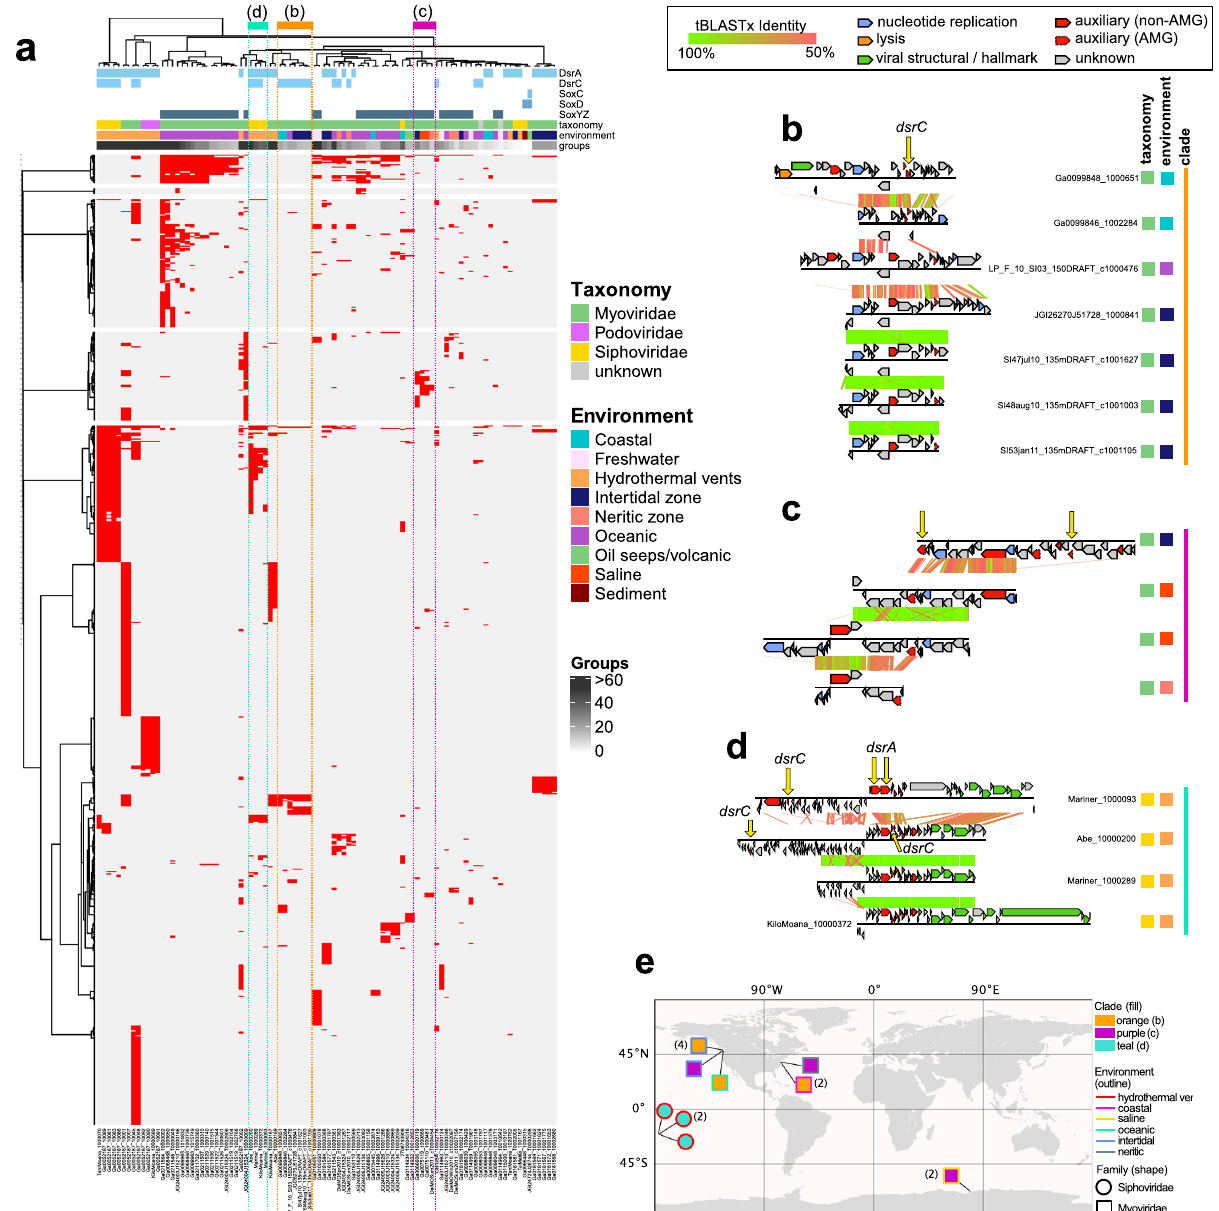
Fig. 5 mVC protein grouping and genome alignments. a mVC hierarchical protein grouping where each row represents a single protein group (887 total) and each column represents a single mVC (94 total). Metadata for encoded AMGs, estimated taxonomy, source environment and number of protein groups per mVC is shown. Clades respective of b , c , and d are depicted by colored dotted lines. Genome alignments of b seven divergent Myoviridae mVCs encoding dsrC from diverse environments, c four divergent Myoviridae mVCs encoding soxYZ from diverse environments, and d four divergent Siphoviridae mVCs encoding dsrA and dsrC from hydrothermal environments. For the genome alignments, each black line represents a single genome and arrows represent predicted proteins, which are colored according to VIBRANT annotations; genomes are connected by lines representing tBLASTx similarity. e Map of geographic distribution of 15 mVCs depicted in b , c , and d annotated with respective clade, source environment, and taxonomic